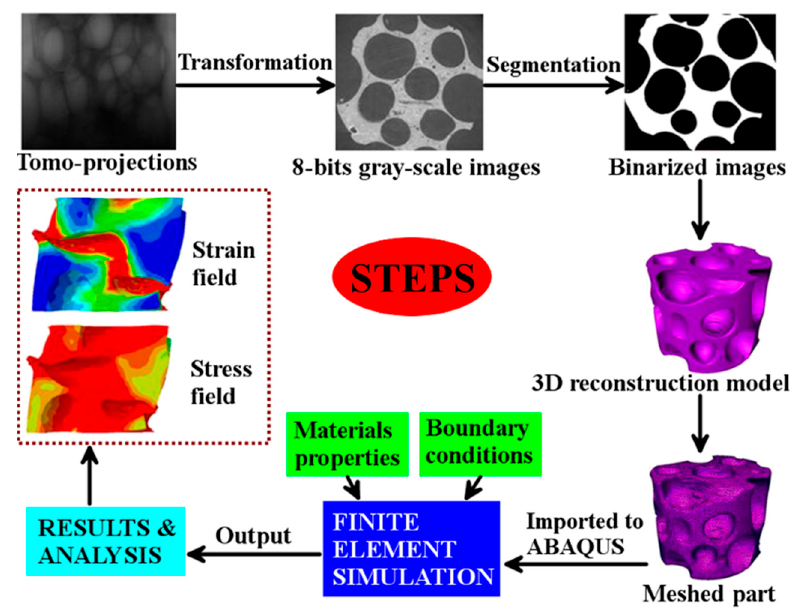
Figure 2. Detailed procedure of model reconstruction and simulation.